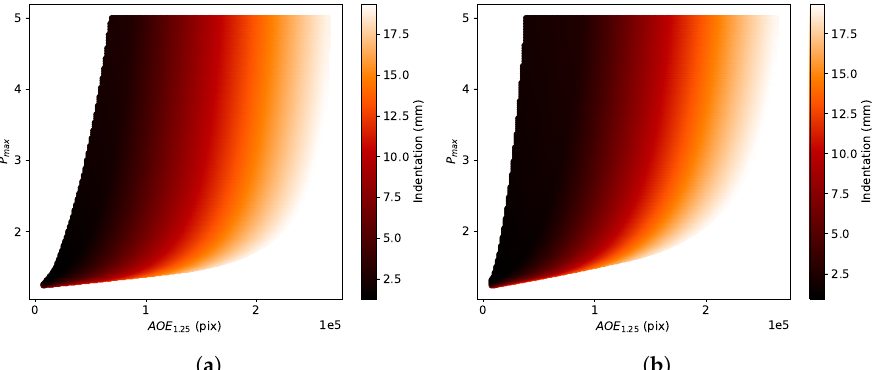
Figure 5. Change in estimated indentation with AOE 1.25 and P max for ( a ) DF and ( b ) VW mate- rial models.